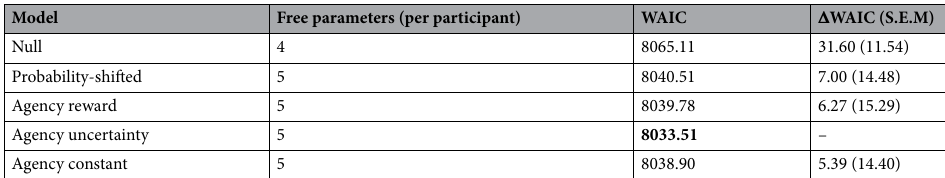
Table 1. Watanabe-Akaike Information Criterion (WAIC) for each of the discussed models. A smaller value indicates a better fit to the data. The WAIC for the best fitting model is highlighted in bold. The difference from the best-fitting model is represented as (cid:31)